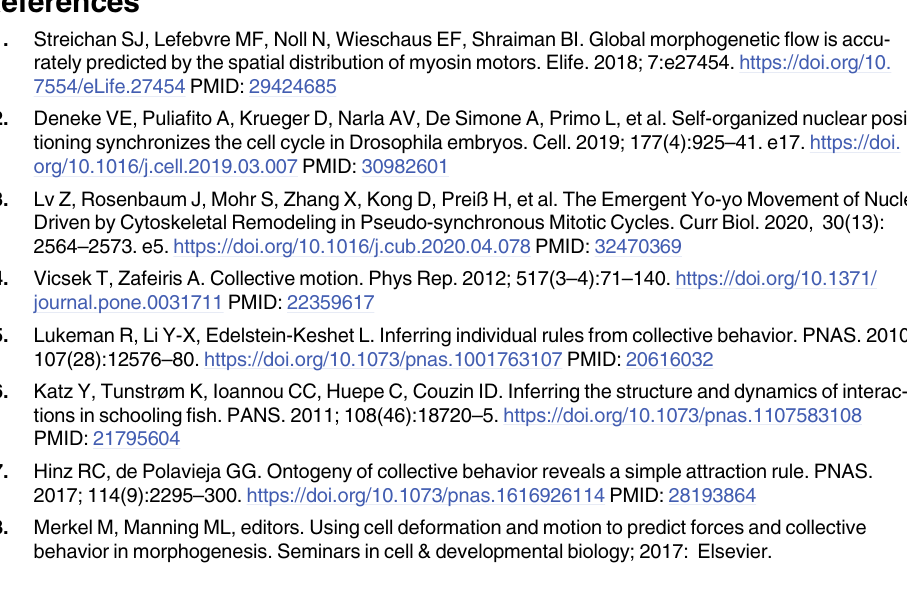
S6 Movie. The particle-based model simulation based on the F r assumption. Red and green represent the left (anterior) and right (posterior) direction, respectively. And the intensity indi- cates the magnitude of the nuclear